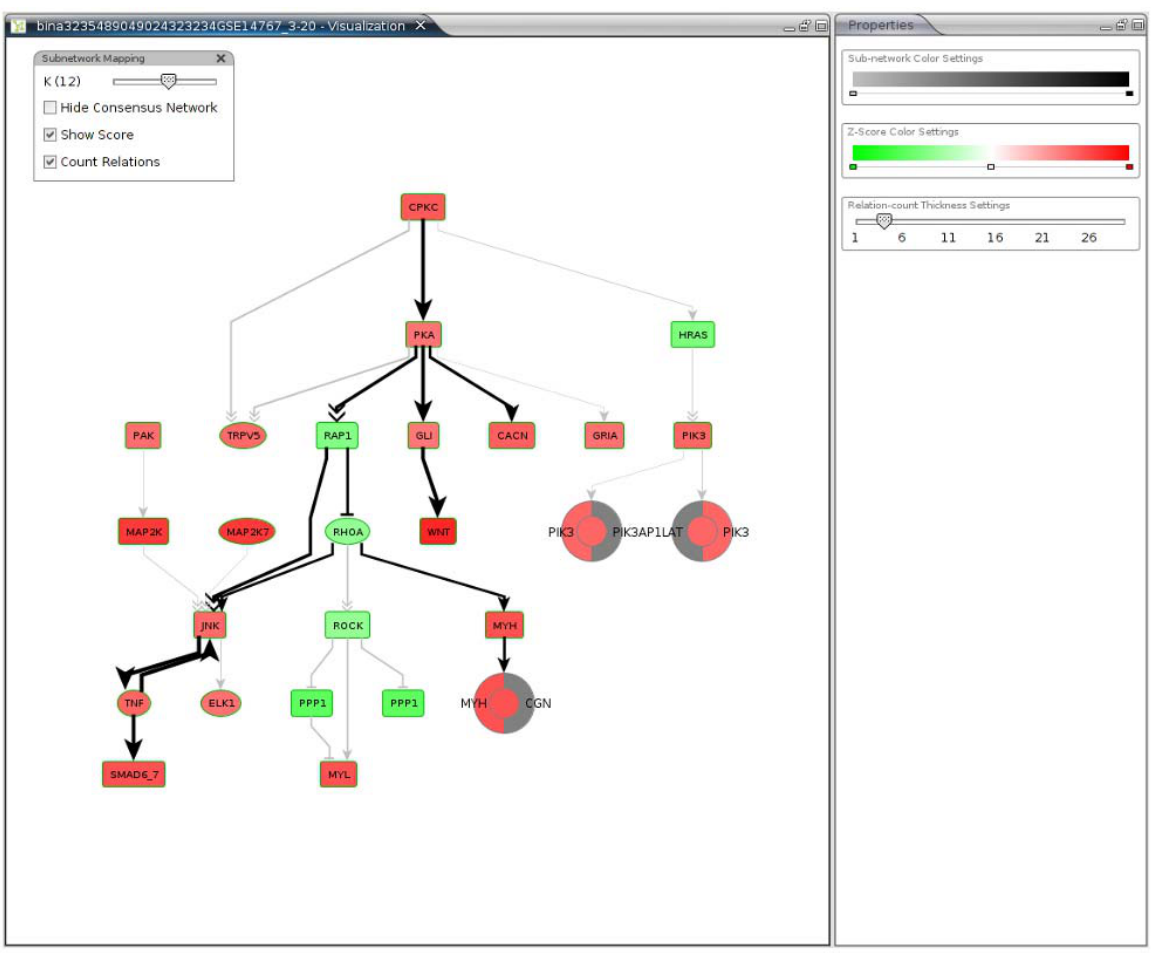
Figure 6. NetworkTrail Application. The results of NetworkTrail can be visualized using BiNA Webstart. The NetworkTrail plug-in of BiNA provides interactive navigation through the found subnetworks using the toolbox in the top-left corner of the visualization, which supports the evaluation of the results. It is easily possible to switch to a certain subnetwork of size k, or to hide the consensus network, which is the union of all found subnetworks. It is also possible to show or hide the score and the number of relations an edge represents. On the right-hand side, the user can adjust some basic visual mapping properties.